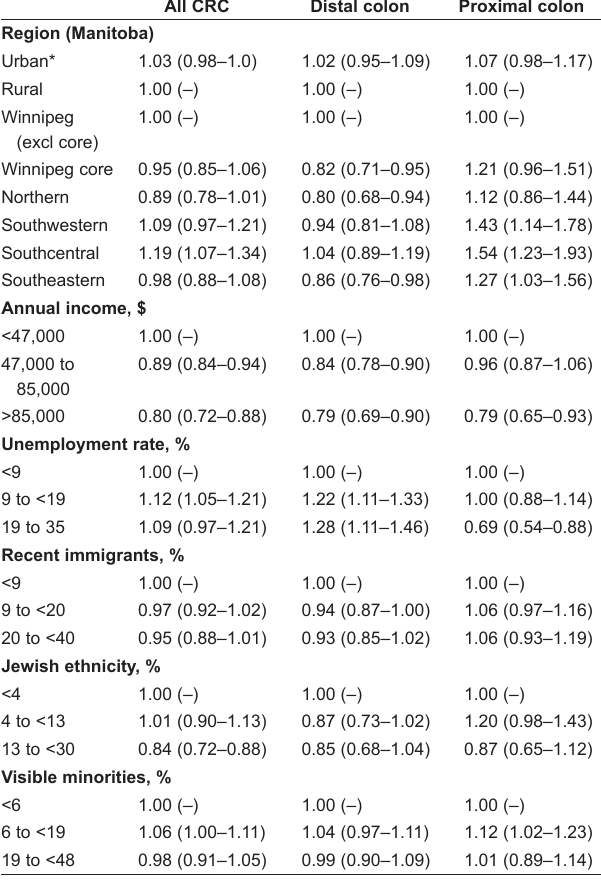
TABle 3 Age- and sex-adjusted Poisson regression analyses of colorectal cancer (CRC) mortality, 1985 to